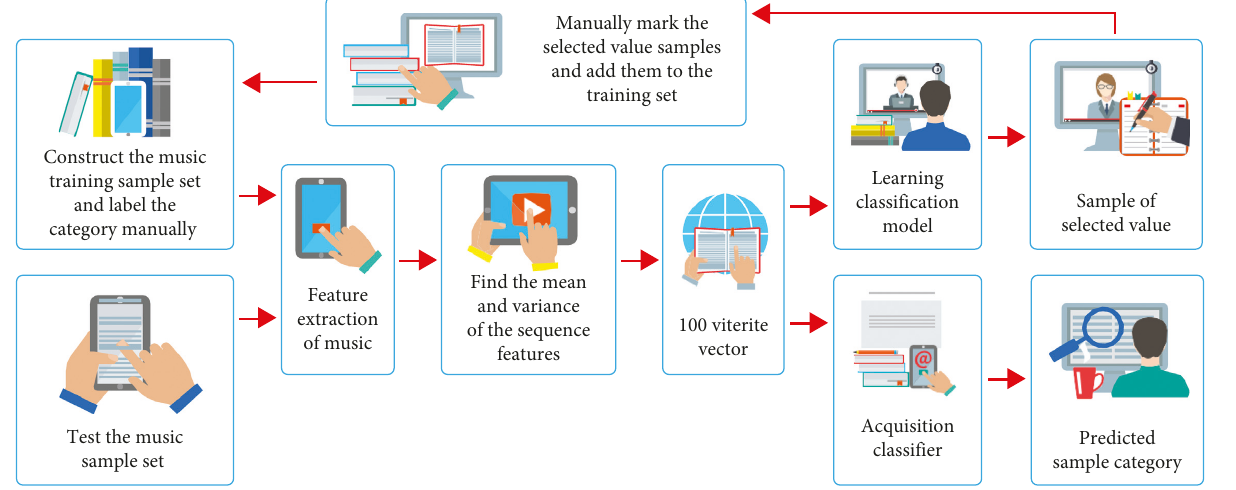
Figure 1: Principle block diagram of active learning music